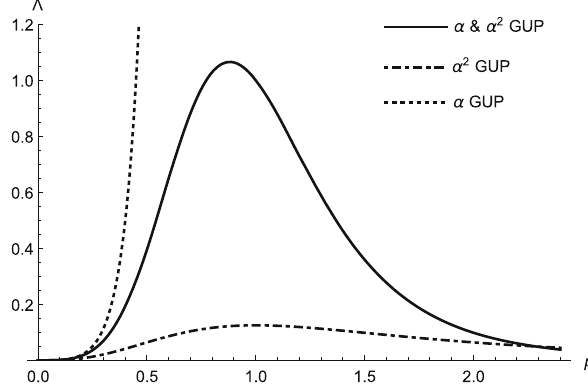
Fig. 1 The behavior of weight factor ( 1 − α p + α 2 p 2 ) − 4 of LQGUP compared to ( 1 + β p 2 ) − 3 of Ref. [20] when D = 3. The horizontal axis is the logarithm of every weight factor. We have set α 2 = β = 1 of energy, holographic entropy, and cosmological constant.